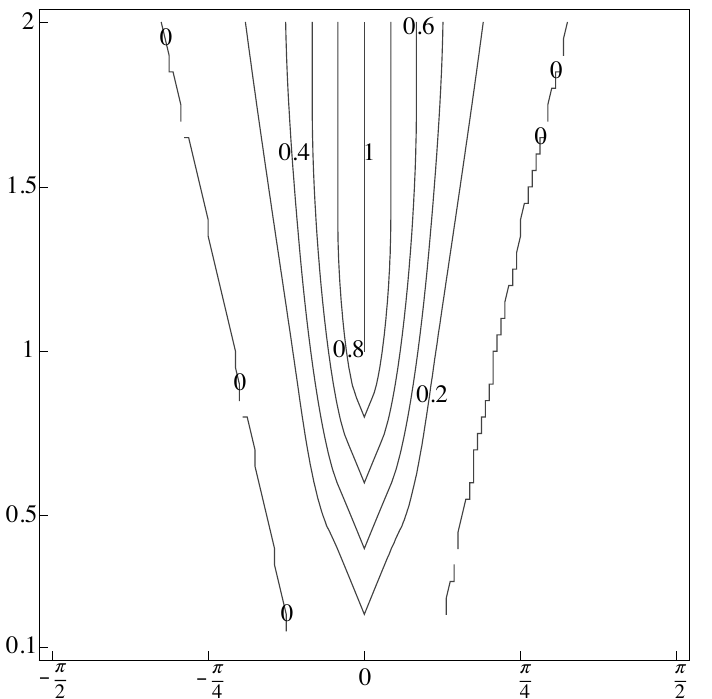
Figure 6. Response for varying pre-known localized target size and localized target orientation of the DoB, having optimal